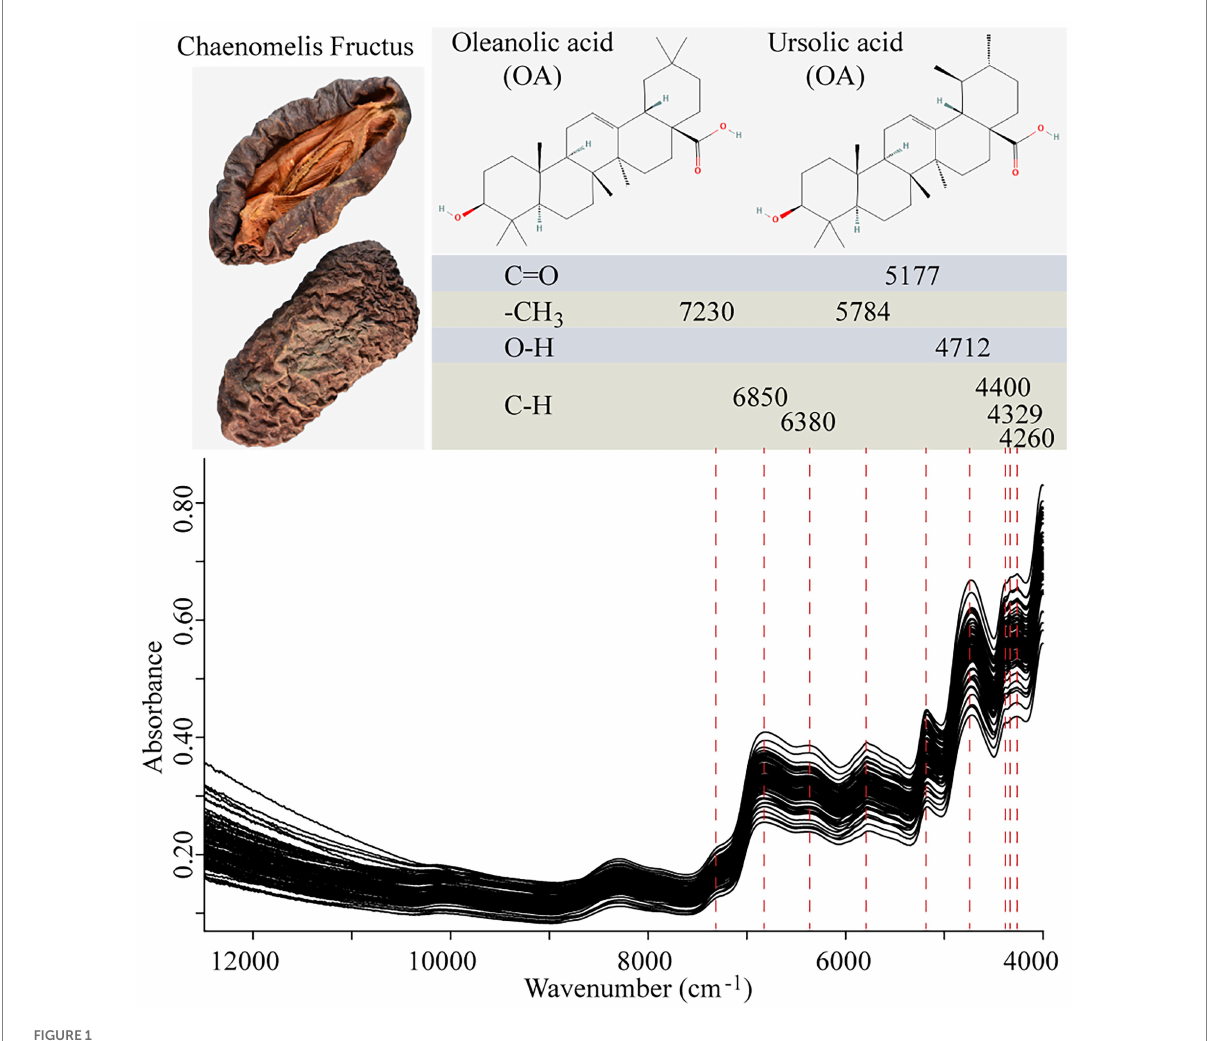
FIGURE 1 NIR spectra of